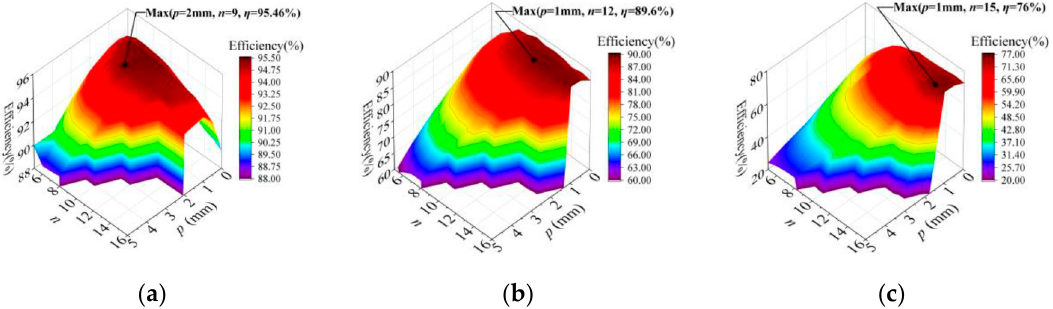
Figure 9. PTE of sensor coil with different values of n and p , at distances of ( a ) 5 cm, ( b ) 10 cm, and ( c ) 15 cm.